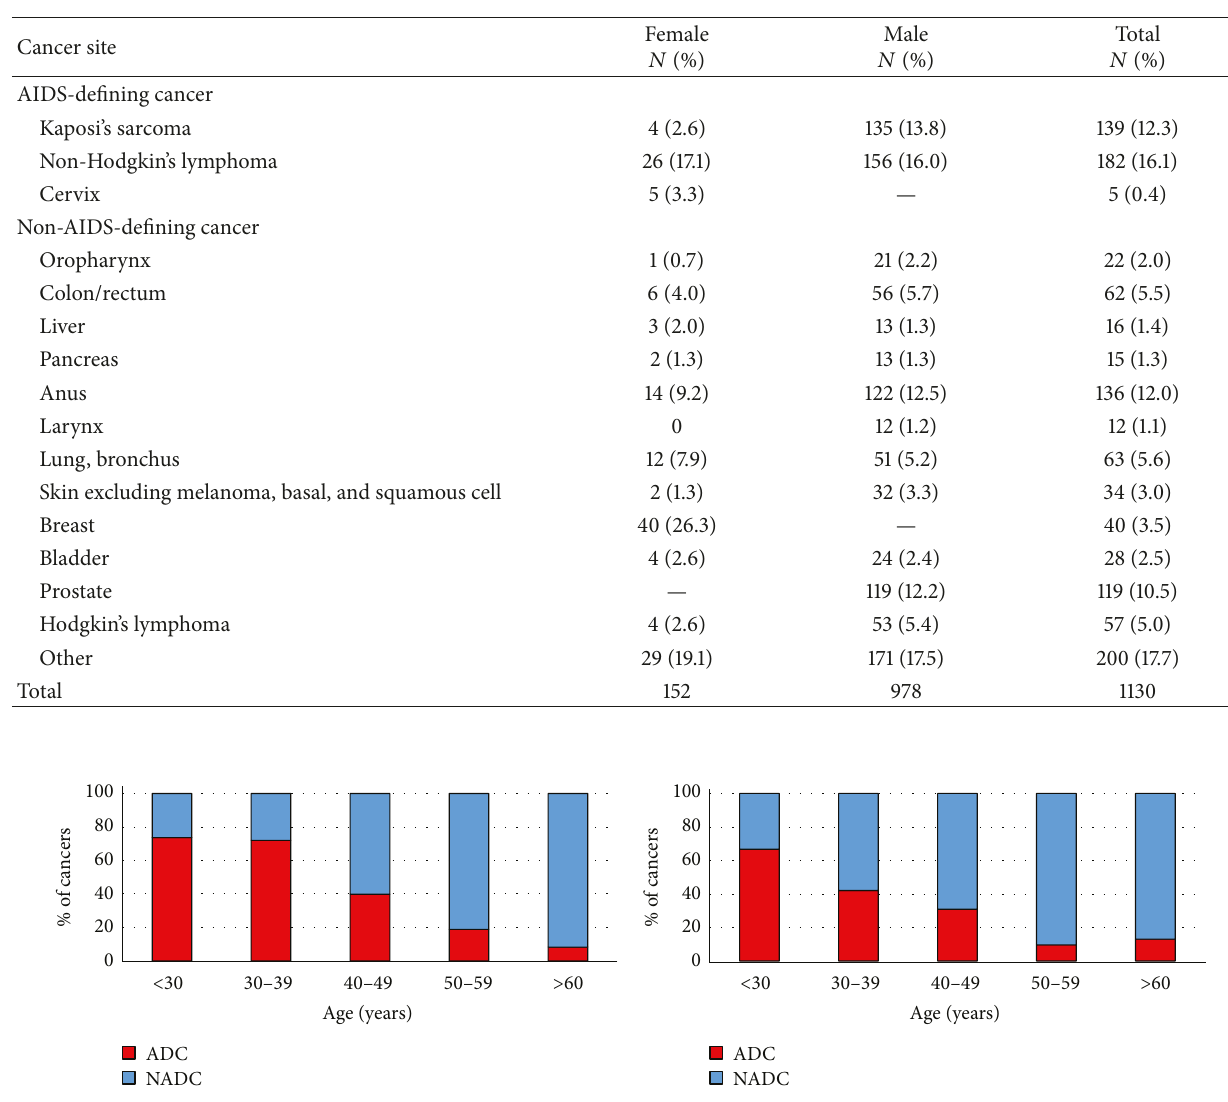
Table 2: Cancer cases among HIV-infected persons.